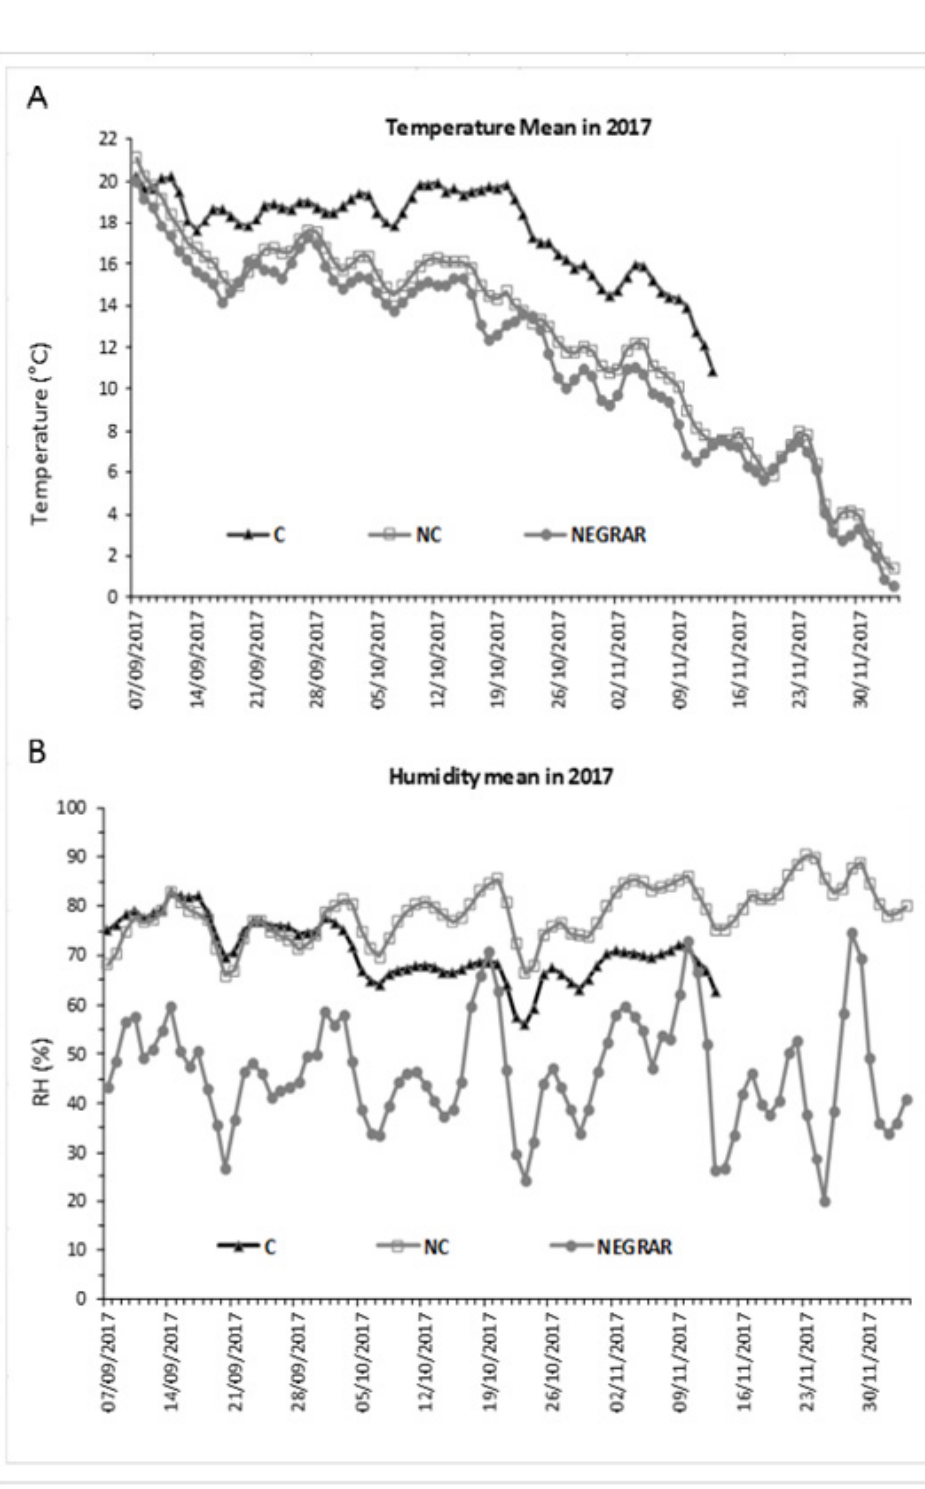
Figure 2. Daily mean air temperature ( A ) and humidity ( B ) in controlled (C) and not-controlled (NC) chambers and outside environment (Negrar) in 2017.